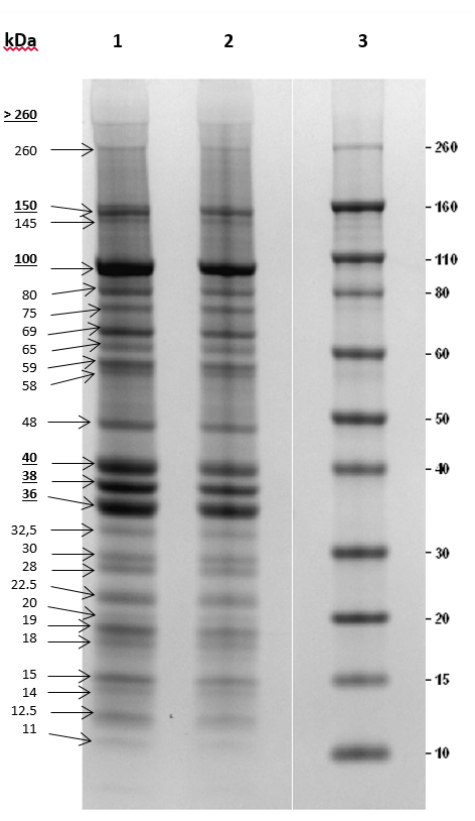
Figure 3 . ɸ IZSAM-1 structural proteins. Lane 1 and 2: ɸ IZSAM-1; lane 3: molecular weight protein Figure 3. Φ IZSAM-1 structural proteins. Lane 1 and 2: Φ IZSAM-1; lane 3: Molecular weight marker . protein